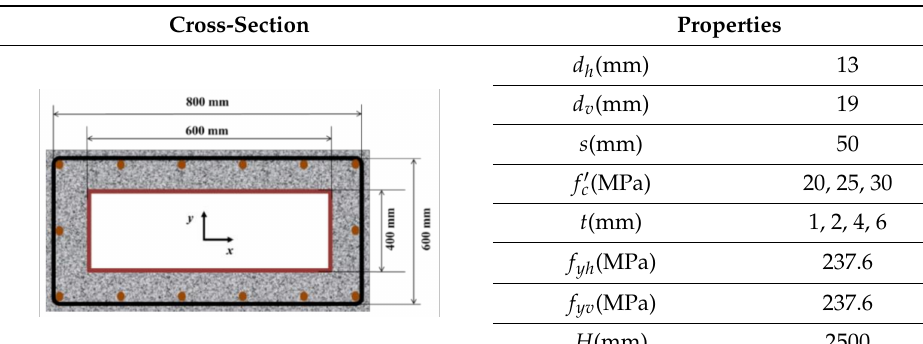
Table 2. Cross-section and specification of the rectangular ICH RC